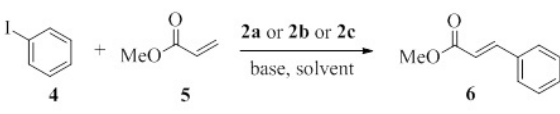
Figure 4 - Mirozoki-Heck reaction of 4 and 5 in palladacycles 2a - c as pre-catalysts.